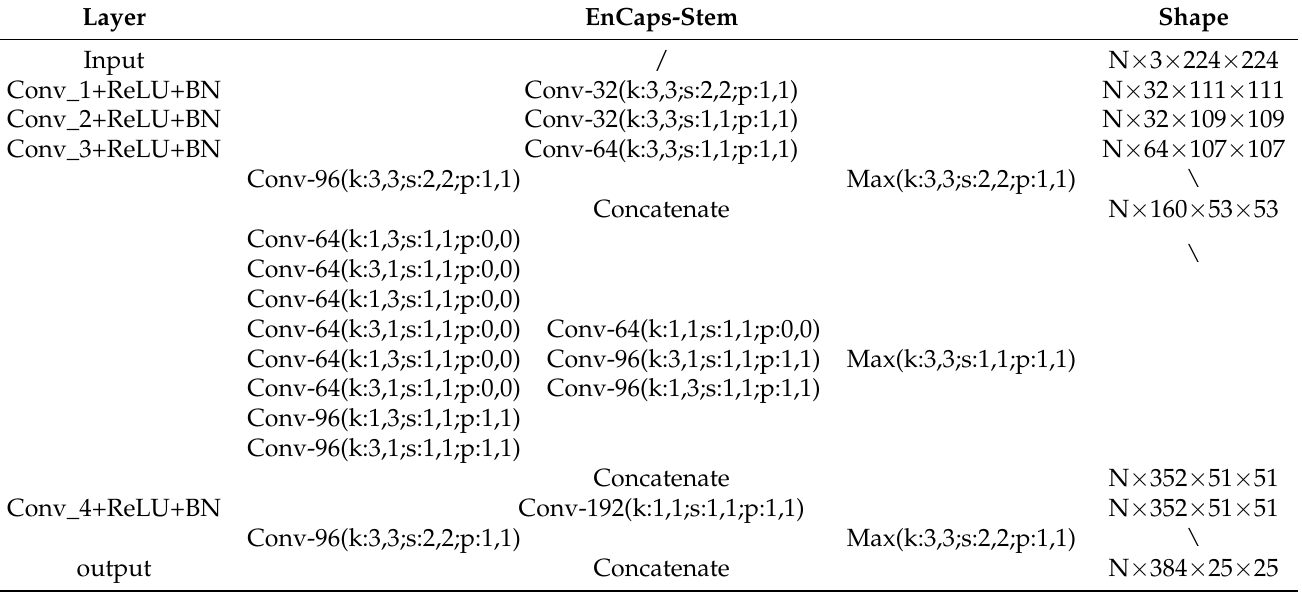
Figure 5. Overview of the Inception mechanism, which belongs to the parameter optimization. C denotes 2D convolution, MP denotes Maxpool, BN denotes batch normalization, and LK ReLU denotes Leaky ReLU. Table 2. The network structure of enhanced feature extraction model. ‘k’ represents ‘kernel’, ‘s’ represents ‘stride’, and ‘p’ represents